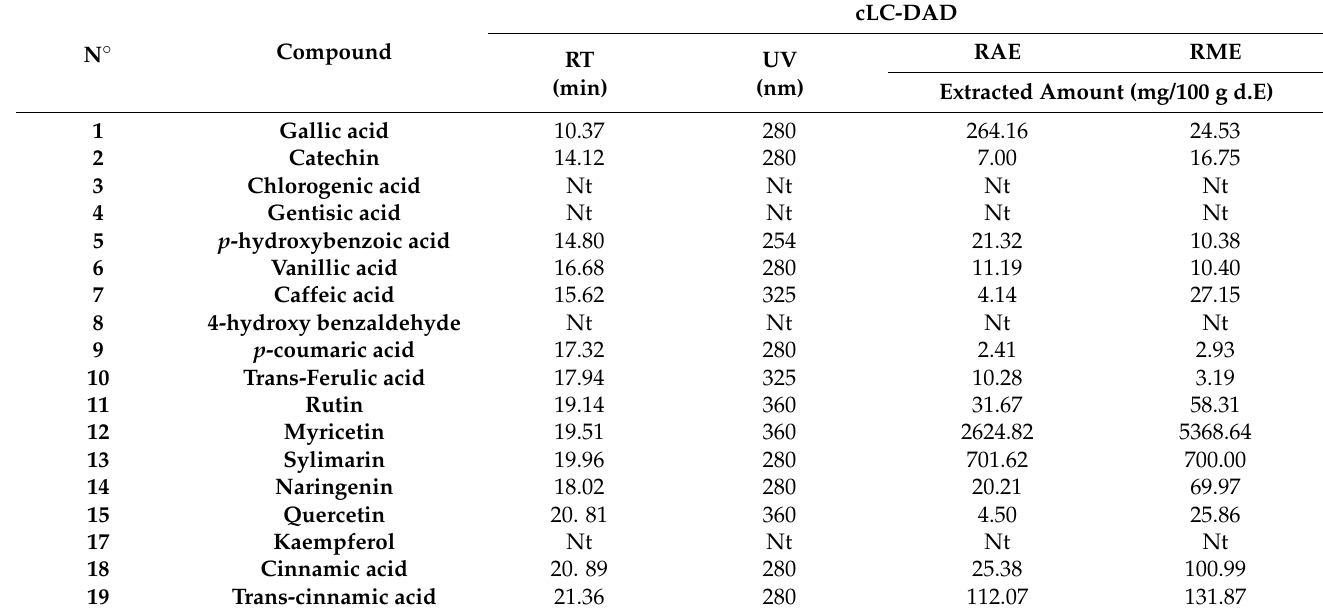
Table 1. Quantification of phenolic compounds in R. tuberculata extracts using cLC-DAD system.